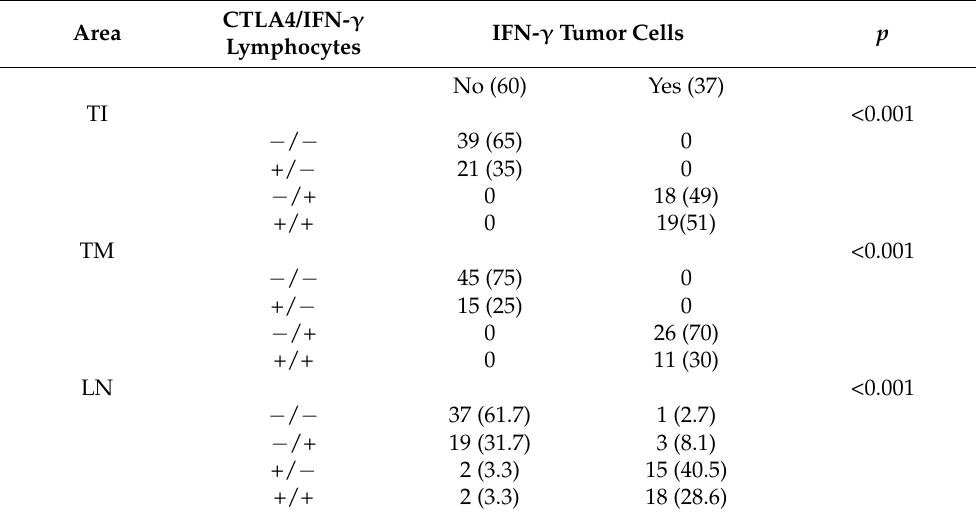
Figure 5 . The expression of IFN- γ and immunosuppressive T cells in the tumor microenvironment at tumor margin (TM); intestinal type (stage 1A) with IFN- γ -positive tumor cells (arrowheads) and a significant number of CTLA-4 + / IFN- γ + T lymphocytes (arrows). Scale bar 25 µm. Table 5. The correlation of the CTLA-4/IFN- γ lymphocytes with the PD-L1 status of GC. Table 6. Correlation of the CTLA4/IFN- γ lymphocytes with IFN- γ expression in